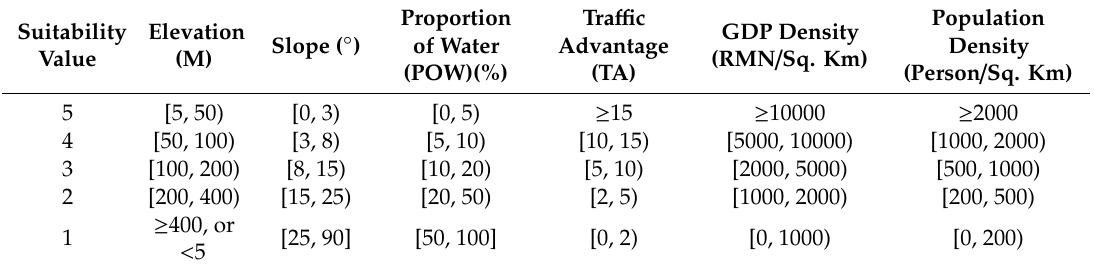
Table 2. Index of land use suitability (LUS) evaluation and classification standard of a ff ecting indicators.